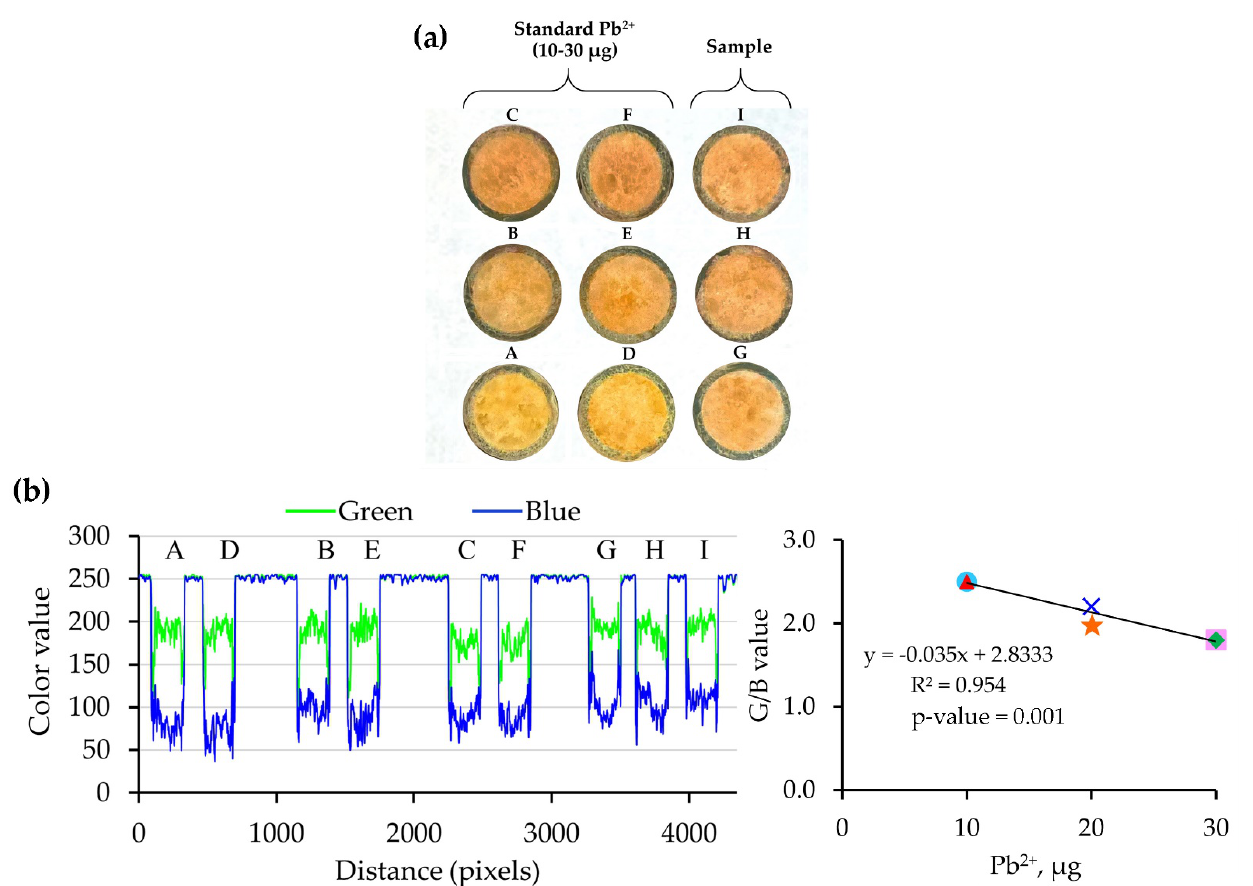
Figure 2. Assay using the proposed procedure for one-shot image of a sample with triplicate results via a single standard calibration approach: ( a ) one-shot photo taken of the nine rods (A − F due to the Pb 2+ standards, G–I due to a sample with different loading volumes); ( b ) profile of G and B values with calibration graph (see Table 1): A ( ), B ( ), C ( ), D ( ), E ( ), F ( ).